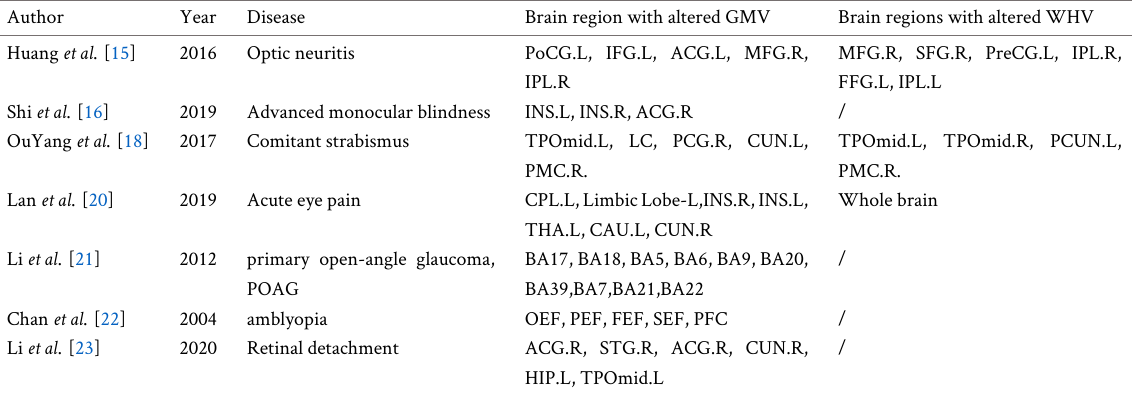
Table 1. VBM used in ophthalmic